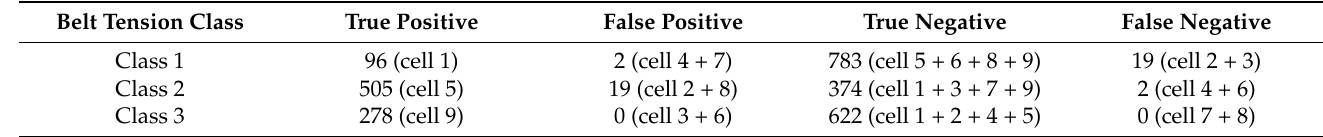
Table 10. TP, FP, TN and FN values of ANN